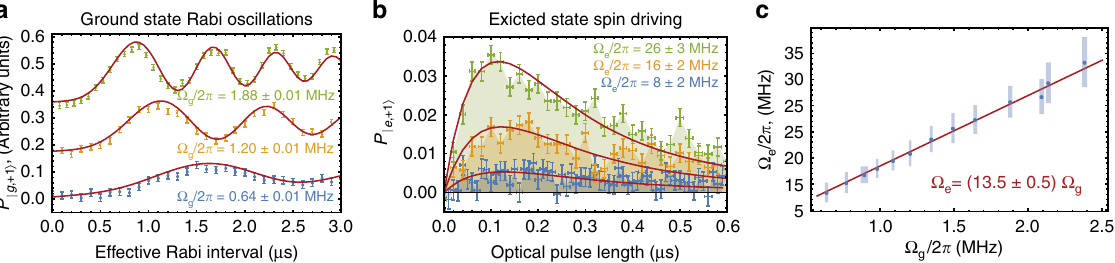
Figure 3 | Quantifying the excited state spin–strain coupling. ( a ) Mechanically driven Rabi oscillations within the ground state (GS) that have been fit using the procedure described in Supplementary Note 2. ( b ) Population in e ; þ 1 j i plotted as a function of t opt . The red curves are least squares fits to a seven-level master equation model of the measurement. The data in a , b were measured on a single device with an NVcentre ensemble, and error bars are from the s.d. in photon counting. ( c ) The excited state mechanical driving field plotted against the GS mechanical driving field and fit with a linear scaling. Each point corresponds to a single measurement, and error bars are standard error from the fits. NATURE COMMUNICATIONS|8:14358|DOI: